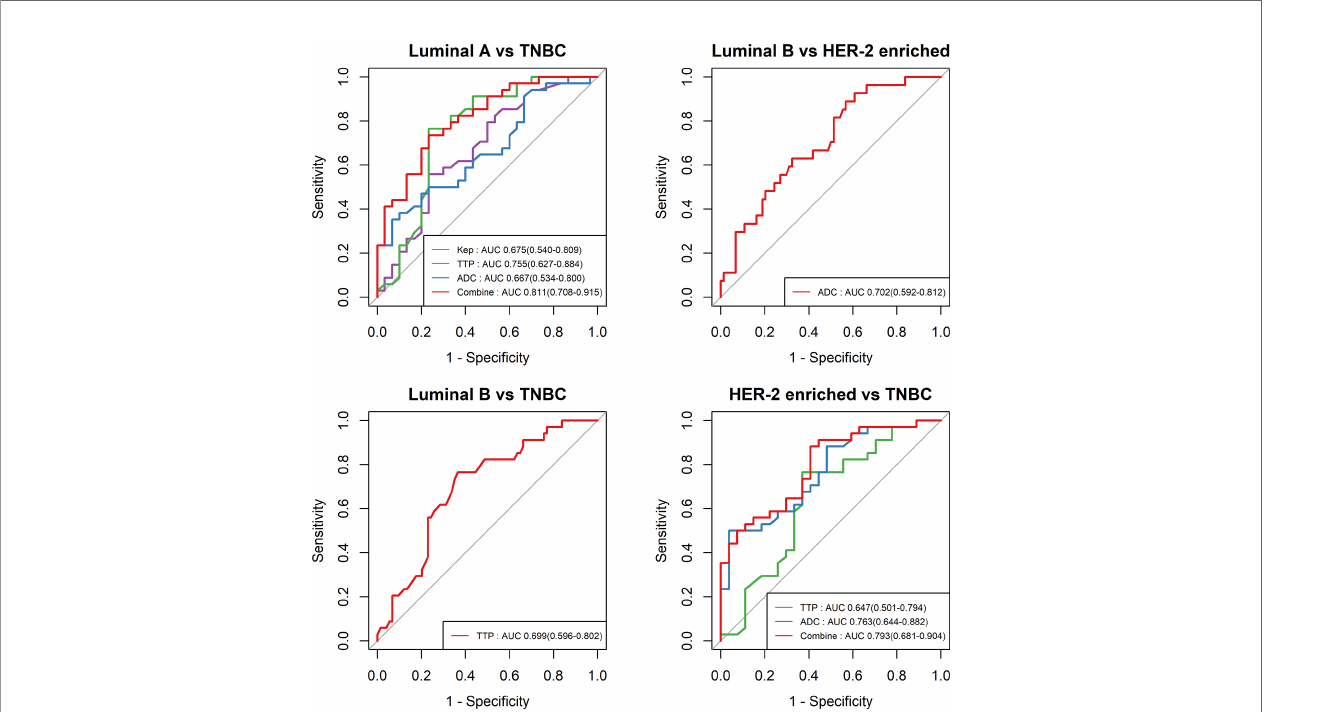
FIGURE 4 | ROC curves of different parameters in the differential diagnosis between luminal A and TNBC, between luminal B and HER-2-enriched BC, between luminal B and TNBC, and between HER-2-enriched BC and